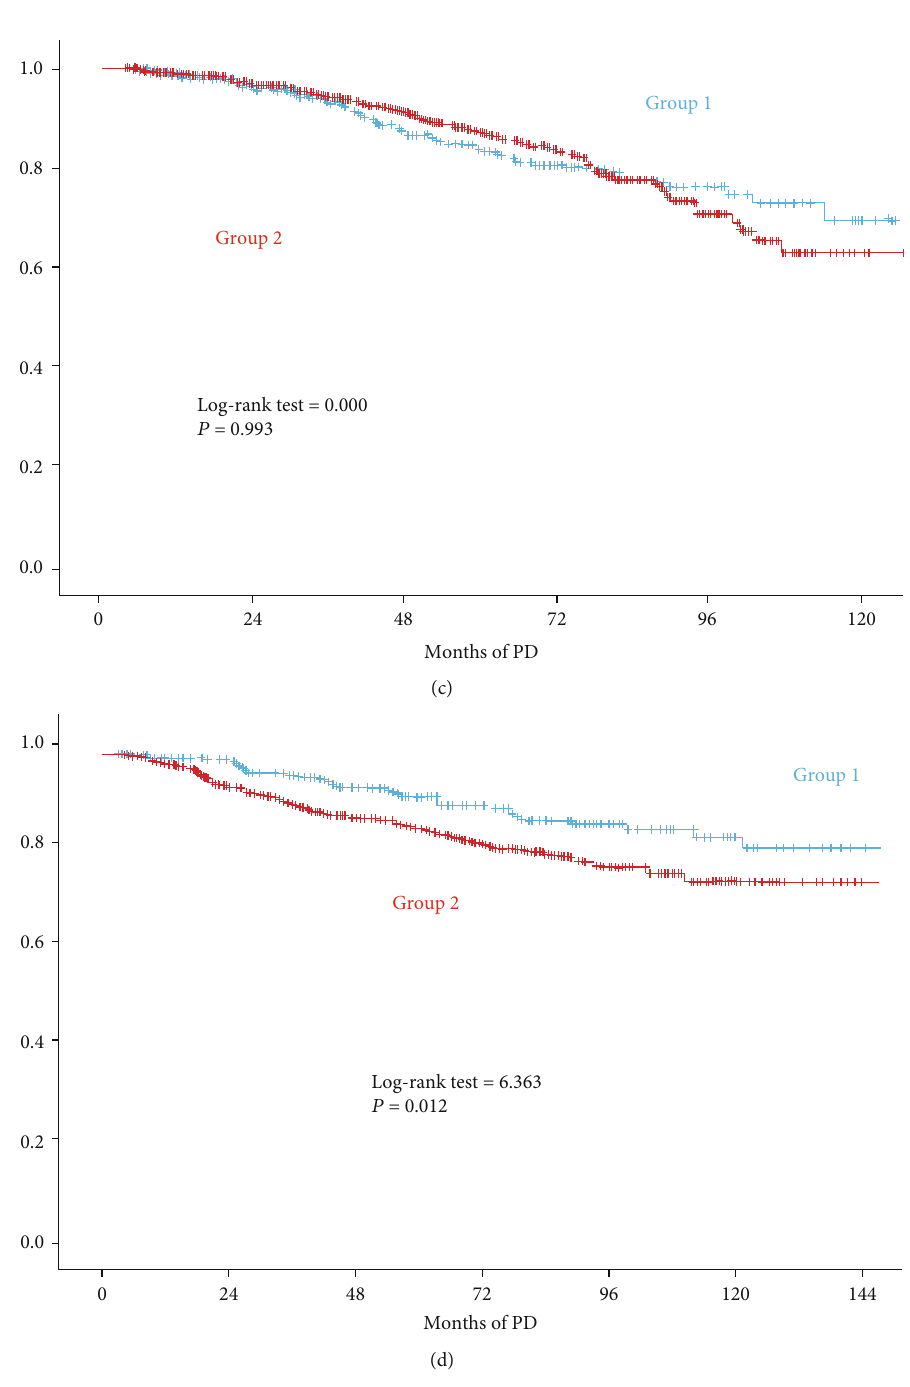
Figure 2: PLR and mortality strati fi ed by sex in peritoneal dialysis (PD) patients. Cumulative risk for all-cause mortality in male patients (a) and female patients (b). Cumulative risk for cardiovascular mortality in male patients (c) and female patients (d). PLR for groups: group 1 ( ≤ 156.43) and group 2 ( >